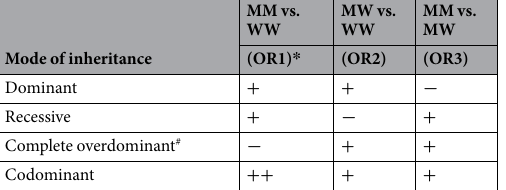
Table 1. Multiple comparisons of genotype effects and possible modes of inheritance. Note: MM: homozygous mutant genotype; MW: heterozygous mutant genotype; WW: wild genotype. * ORi is pooled odds ratio, complete overdominant model: OR2 is at a lesser risk than both OR1 and OR3. + means a significant result; + + means the effect size is greater than + ; − means a non-significant